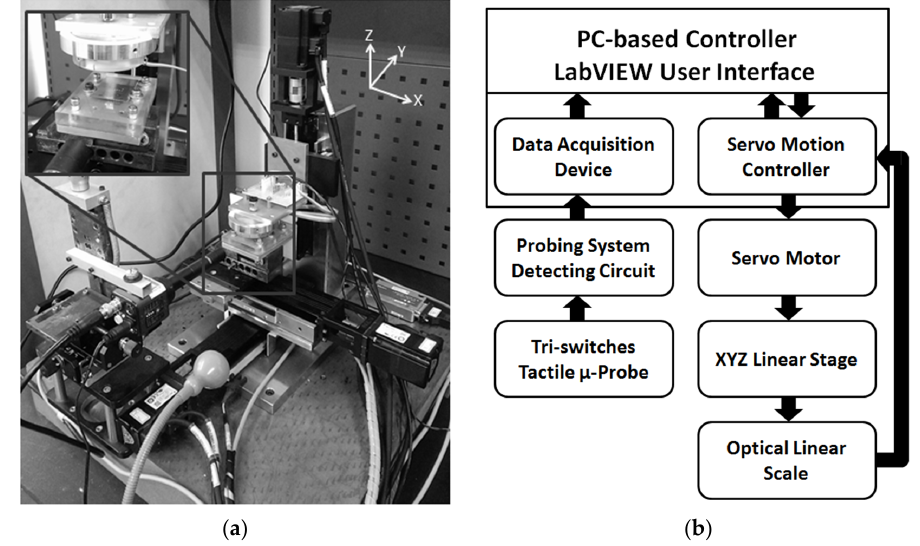
Figure 5. Scheme ( a ) and overview ( b ) of the developed micro ‐ CMM (Coordinate Measuring Machine) system.